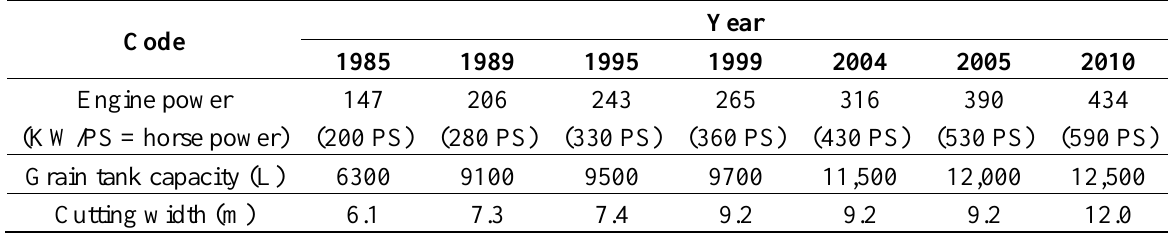
Table 1. Technical development of combine size classes